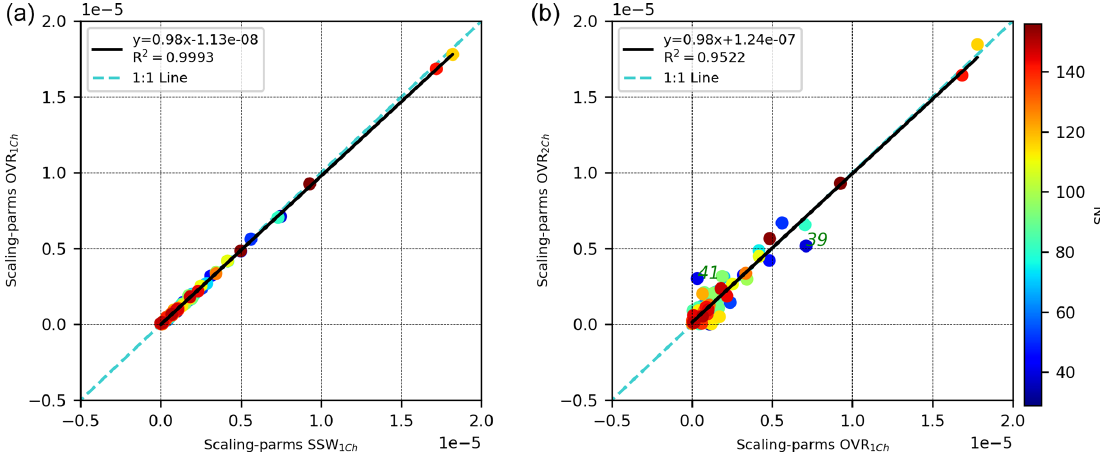
Figure 14. Correlations between the scaling factors derived from OVR and SSW spectral windows using the main channel spectra (a) and using CO channel results for the OVR spectral window (b)